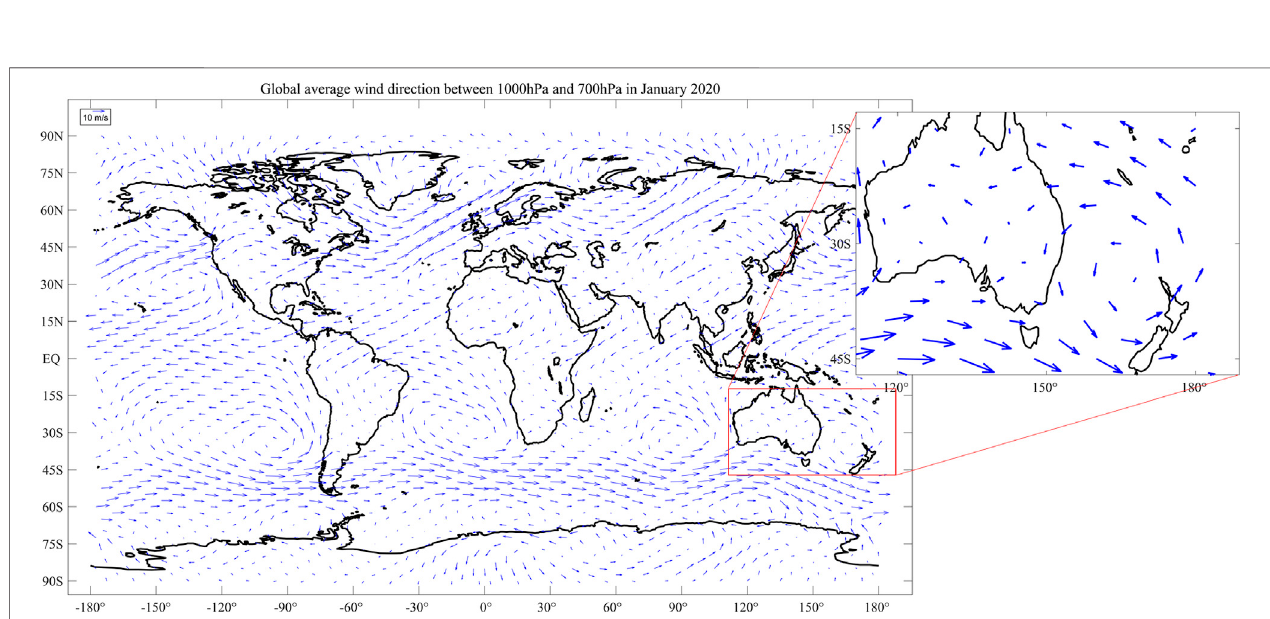
FIGURE 3 | Average global wind direction between 1,000 hPa and 700 hPa in January 2020 and local details of Australia.